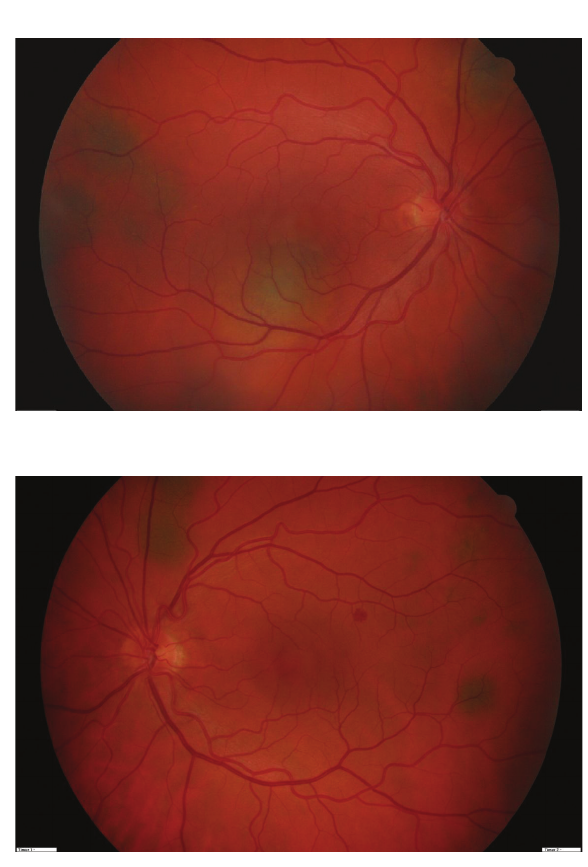
Figure 1: Upper image: funduscopic image of right eye with several placoid pigmented choroidal lesions located in the posterior pole and midperiphery of the retina and serous macular detachment. Lower image: funduscopic image of the left eye with various pigmented choroidal lesions.